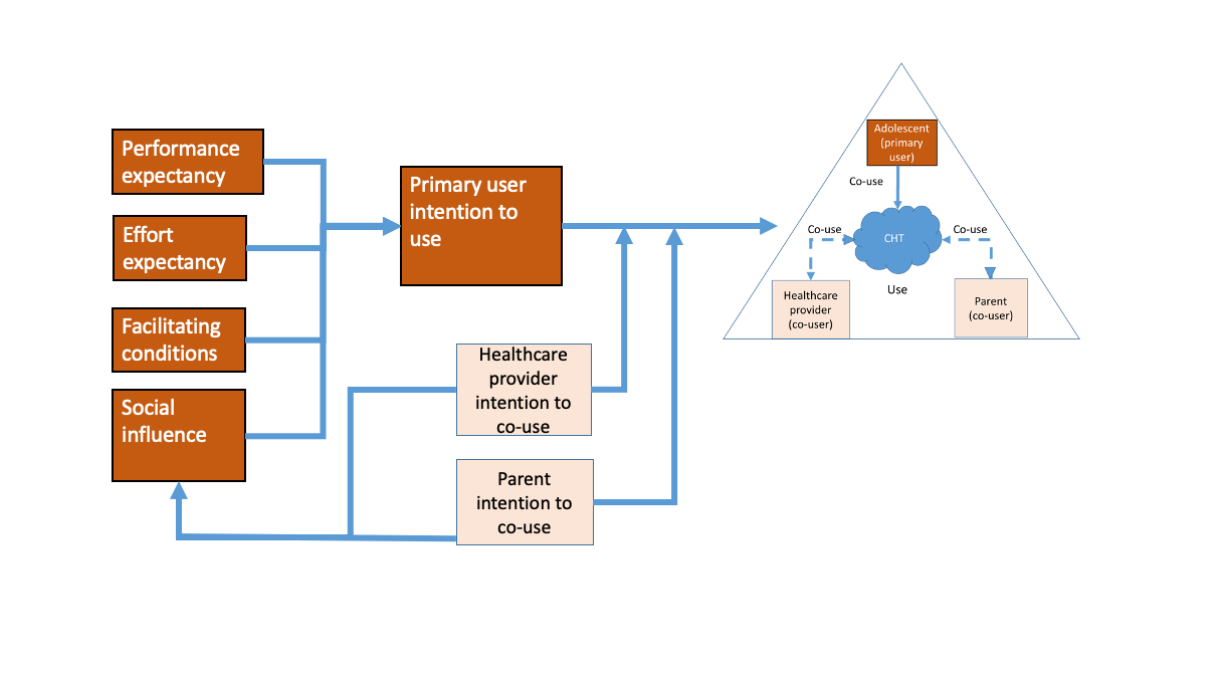
Figure 4. Intention to co-use model. CHT: consumer health